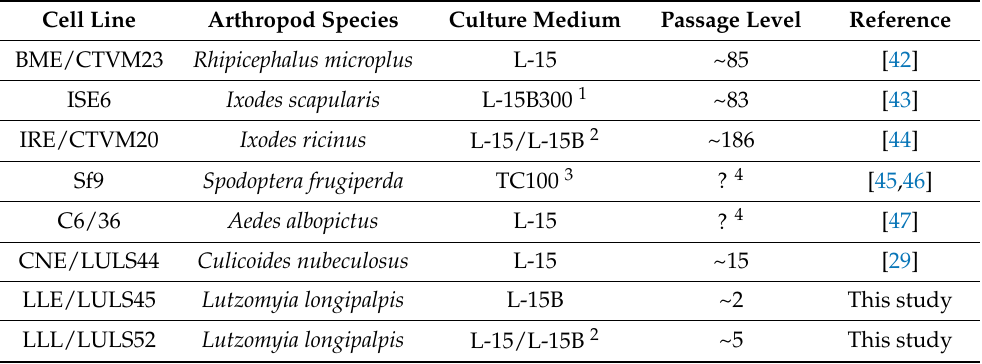
Table 1. Origins of, and culture media used for the propagation of, arthropod cell lines tested for the ability to support growth of Wolbachia strains w Pip and w